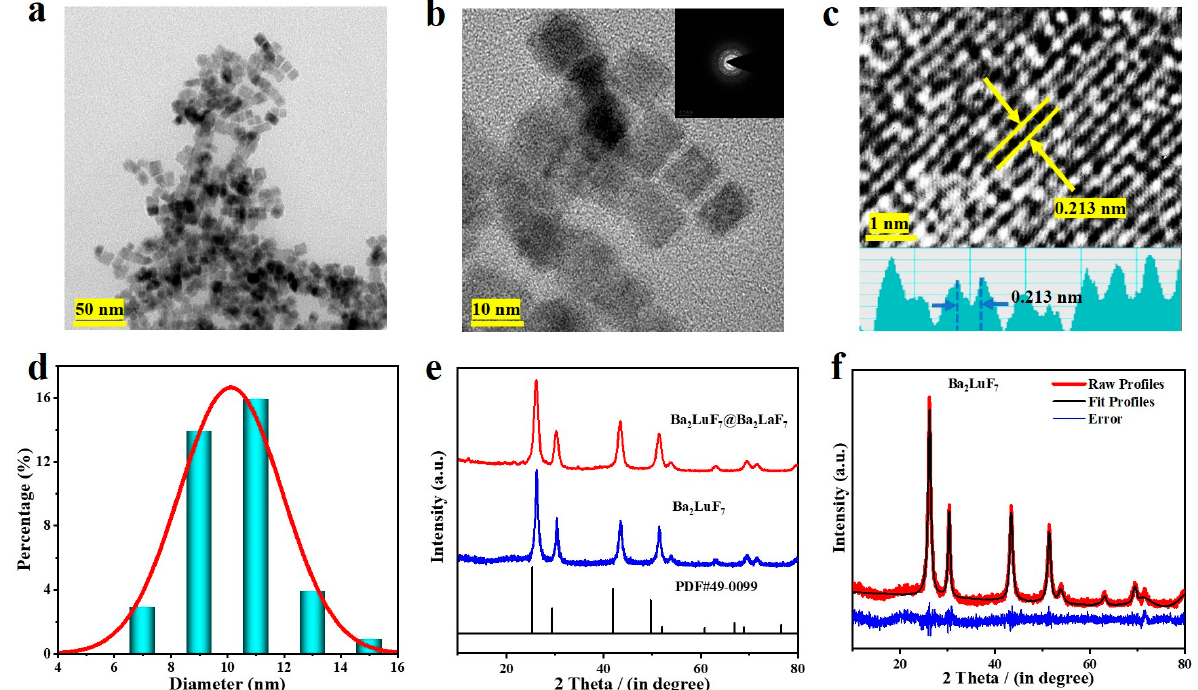
Figure 1. ( a ) Morphological characterization of nanocrystals at 50 nm scales was obtained by TEM. ( b ) Morphological characterization of nanocrystals at 10 nm scales was obtained by TEM. The selec- tive area electron diffraction (SAED) pattern is presented in the illustration on the upper right. ( c ) The high-resolution TEM (HR-TEM) image of Ba 2 LuF 7 @Ba 2 LaF 7 . ( d ) The particle size distribution plot for Ba 2 LuF 7 @Ba 2 LaF 7 . ( e ) XRDs of tri-doped Ba 2 LaF 7 and Ba 2 LuF 7 @Ba 2 LaF 7 nanocrystals were compared with those of standard cards. ( f ) Rietveld XRD refinement for Ba 2 LuF 7 @Ba 2 LaF 7 nanocrys ‐ tals.